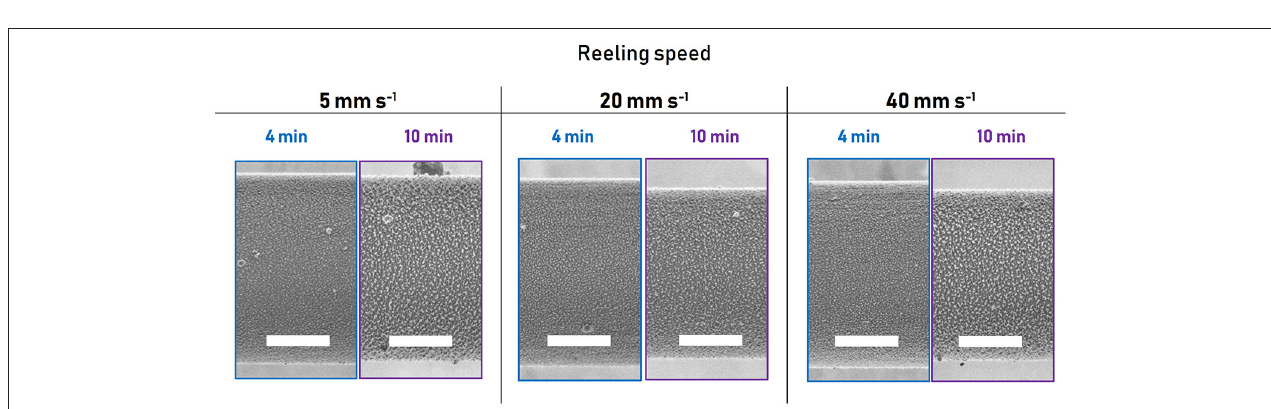
FIGURE 2 | Nanostructures revealed by plasma etching for 4min (blue) and 10min (purple) for the different reeling speeds obtained by regular SE imaging at 1 keV. Scalebars measure 2 µ